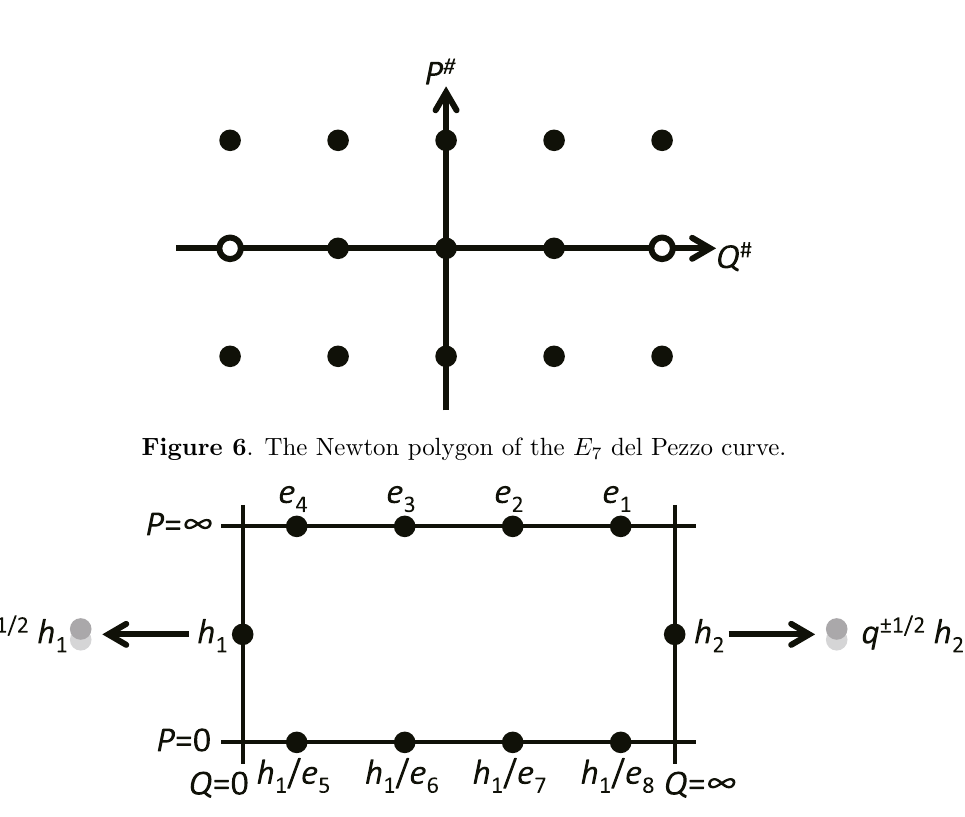
Figure 7 . The asymptotic values of the E 7 del Pezzo